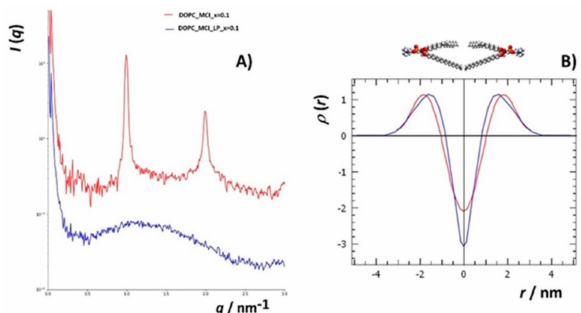
Figure 9. Comparison of the electron densities ( B , normalized to the peak maximum) of DOPC_MCI at molar fraction x = 0.1 (red) and DOPC_MCI_LP at x = 0.1 (blue) obtained from their respective SAXS curves ( A , background